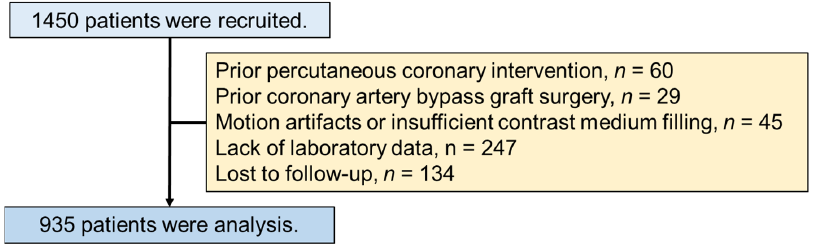
Figure 1. Flow chart of eligibility and exclusion of patients.